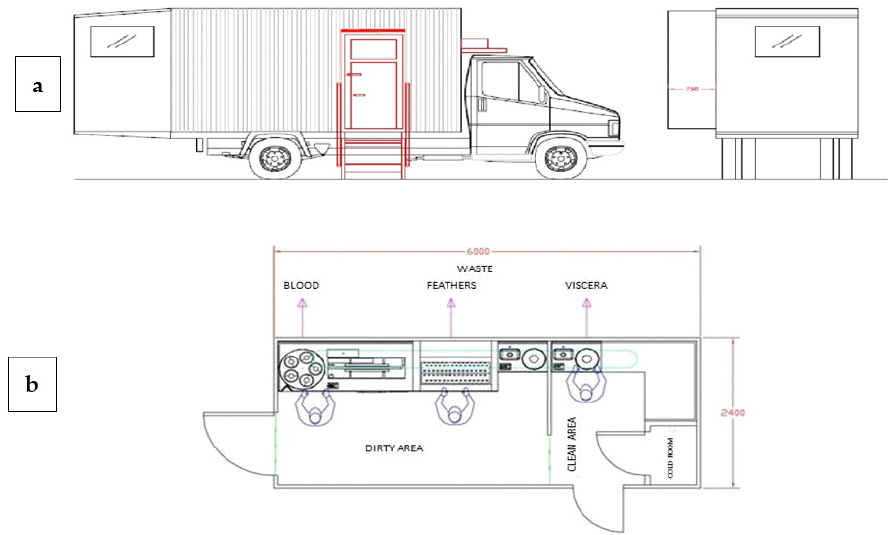
Figure 12. Schematic layout of the Mobile Poultry Processing Unit (50 chickens/hour): external ( a ) and internal ( b ) configuration. Modified by [47].